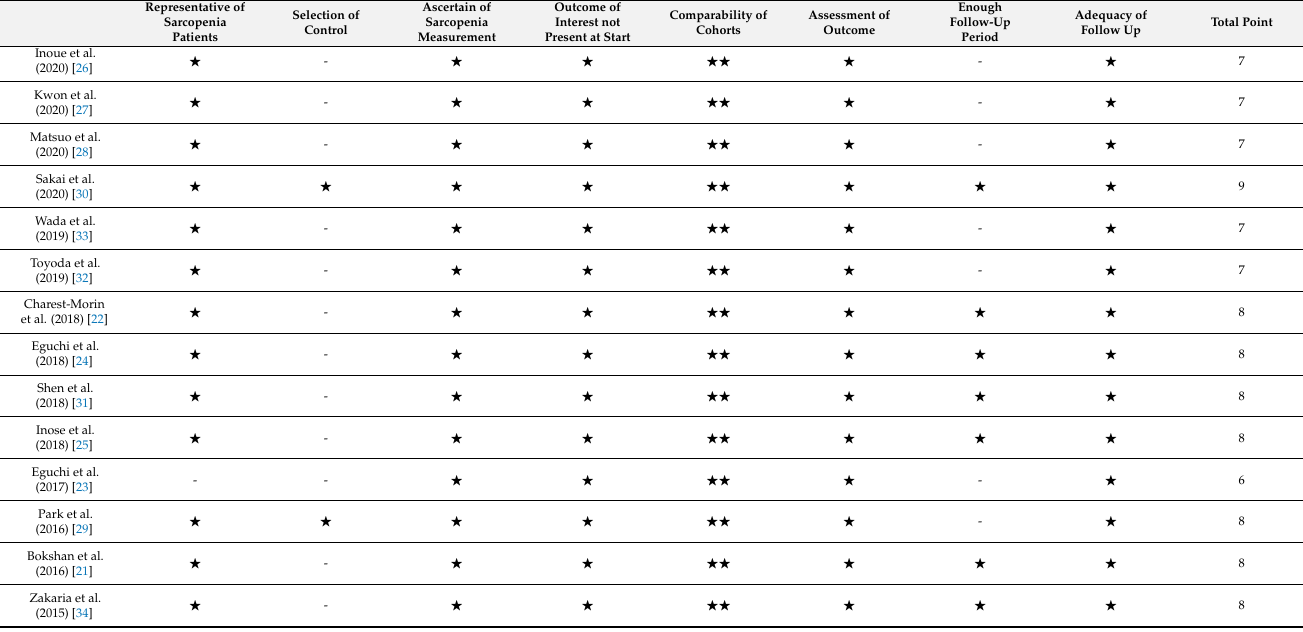
Table 3. Quality Assessment by Using the Newcastle-Ottawa Scale for the Included